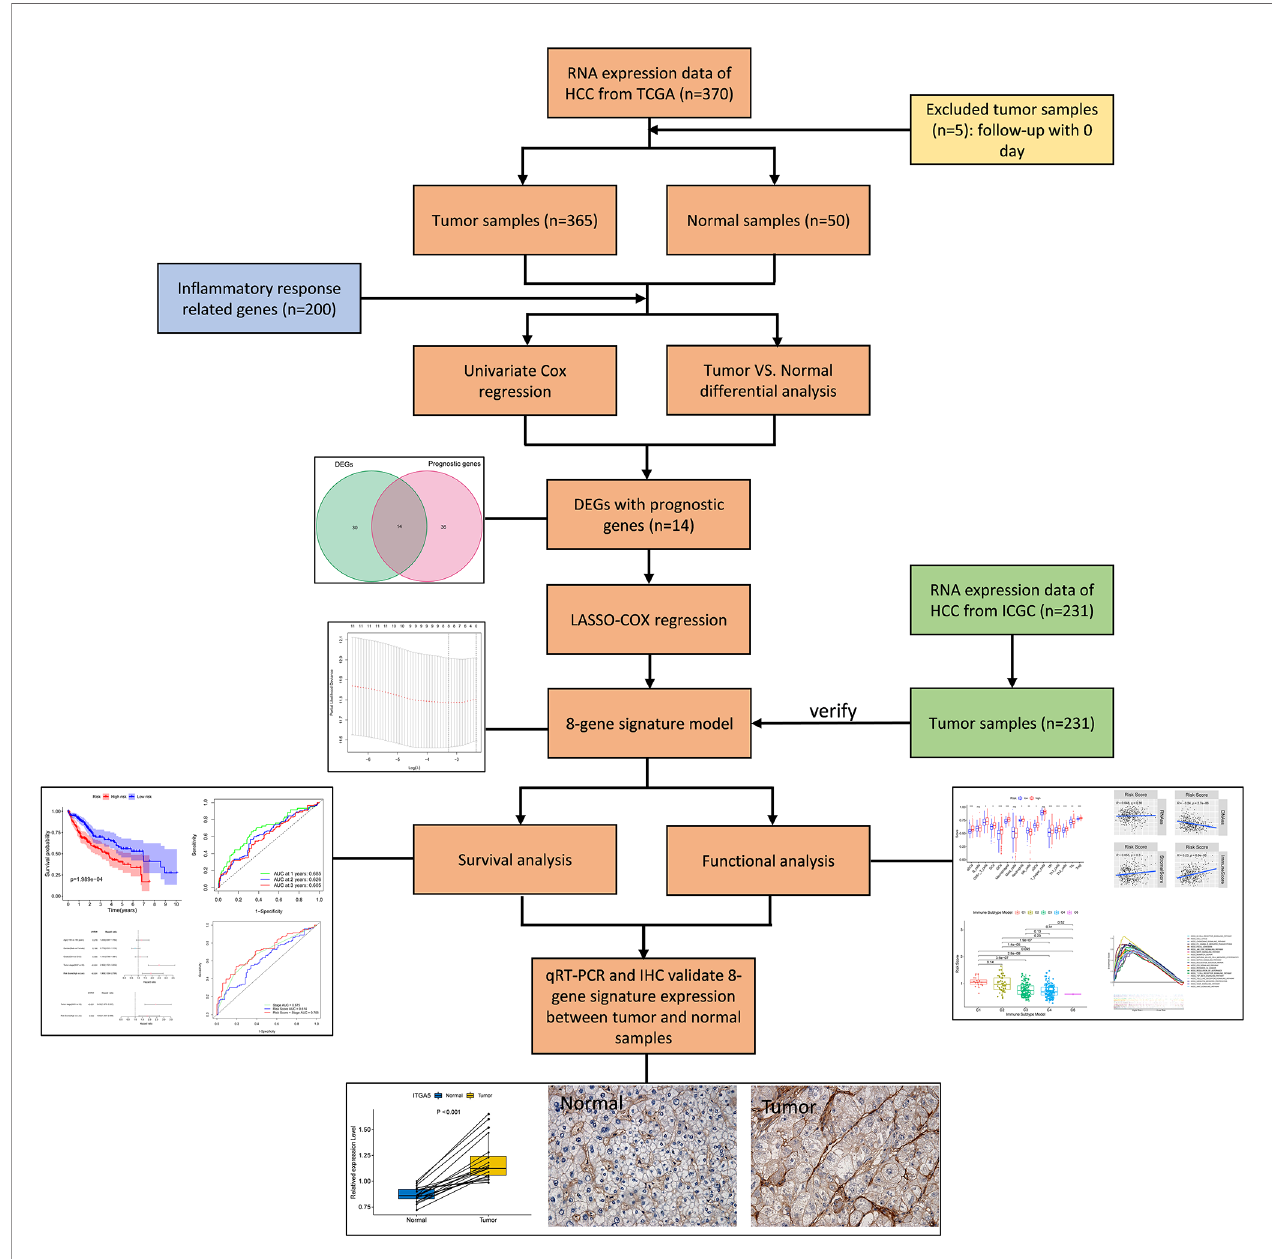
FIGURE 1 | Flow chart of data collection, analysis and